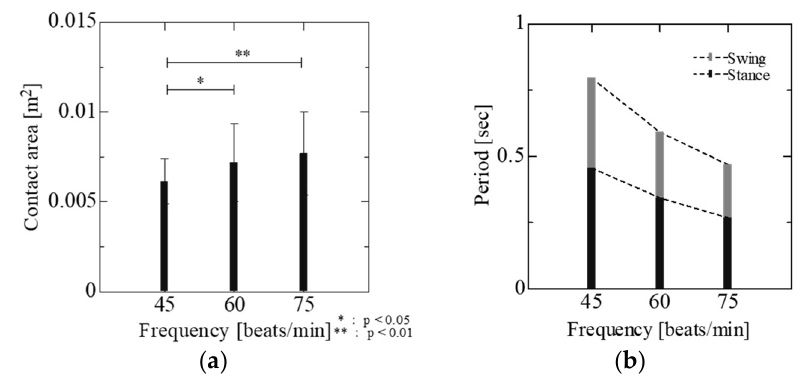
Figure 3. Measured mean gait parameters as a function of gait frequency: ( a ) Contact area; ( b ) Stance and swing durations.